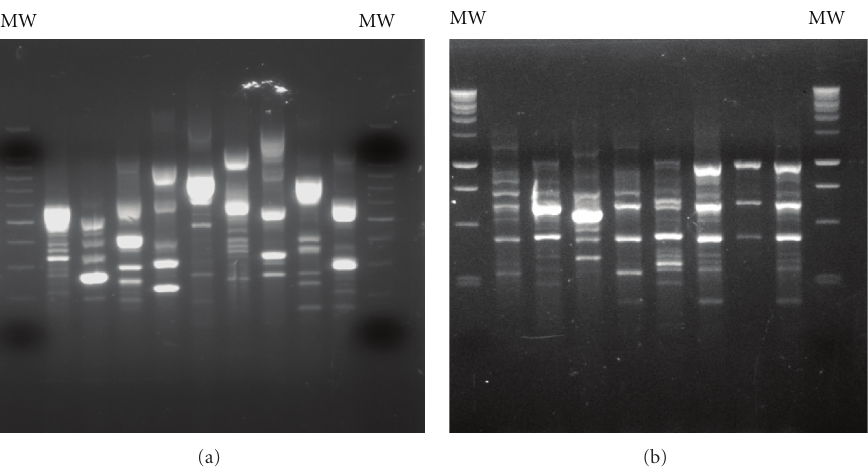
Figure 3: ERIC-2 RAPD patterns of representative Gram negative fermenters (a) and non-fermenters (b). MW = molecular weight. (a) 100bp; (b)